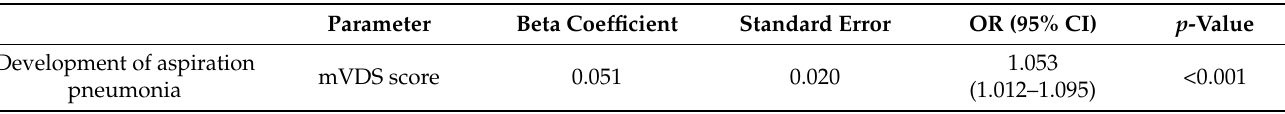
Table 4. Univariate logistic regression analysis (with the enter method) of the association between the modified version of the Videofluoroscopic Dysphagia Scale and the development of aspiration pneumonia.